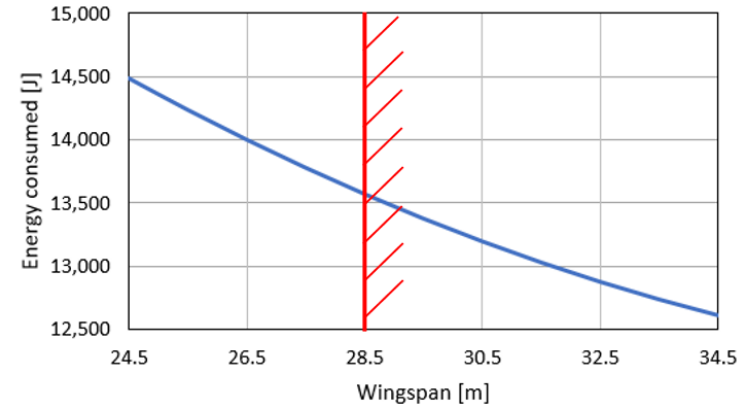
Figure 5. Energy requirements for a given